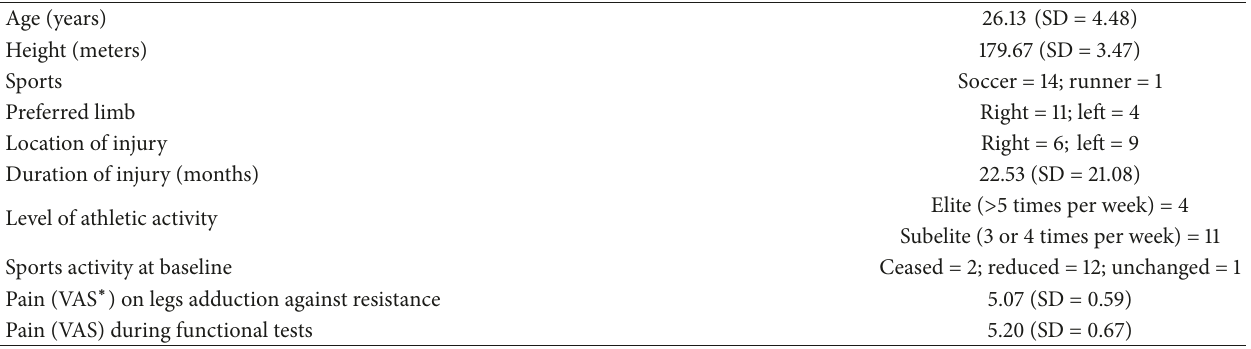
Table 3: Baseline characteristics of the participants ( 𝑛 = 15 ).